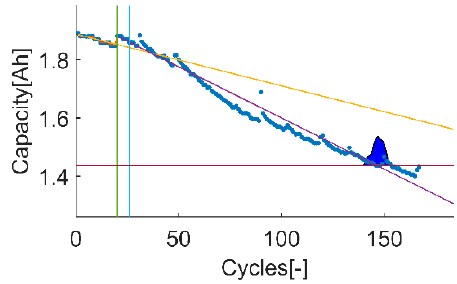
Figure 11. Time-instant figure of test 1 on t 11 .